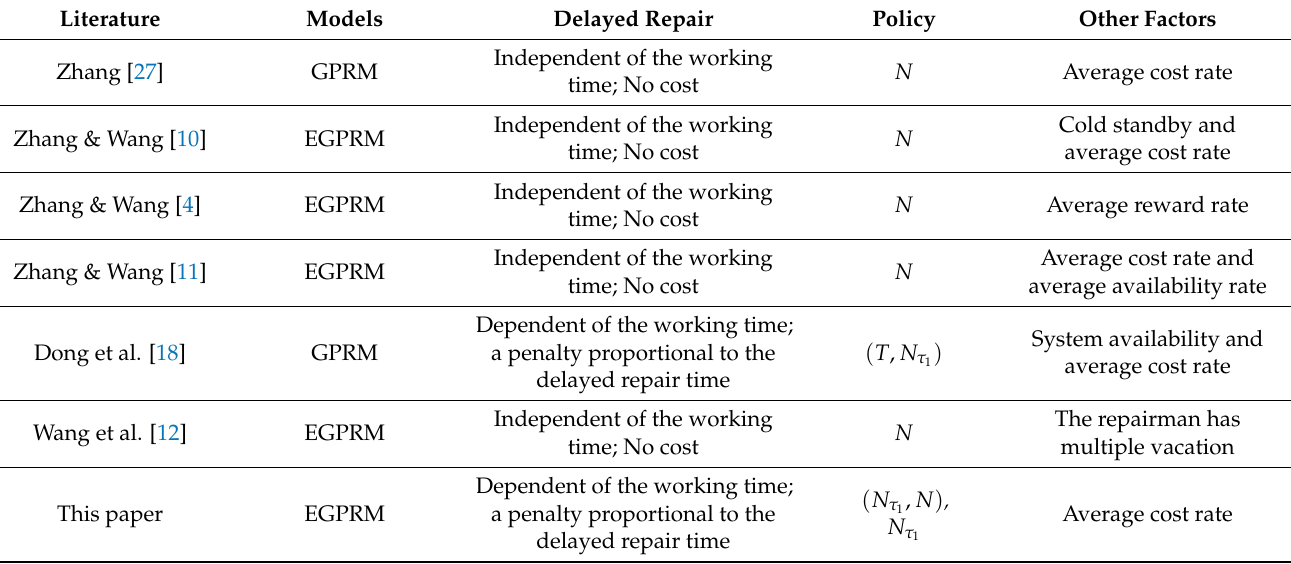
Table 1. A summary of the existing results on similar topics to this